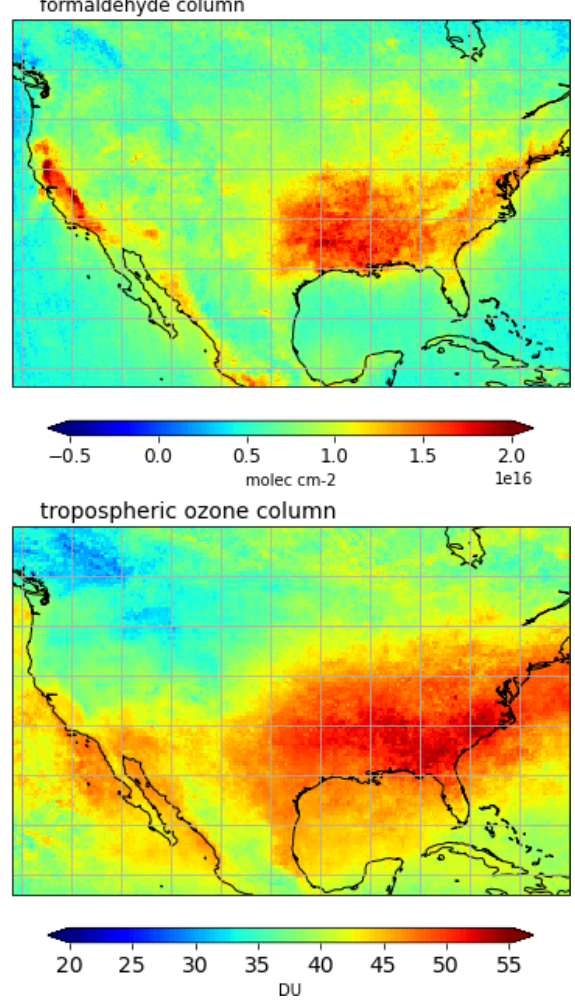
Figure 14. Monthly mean value of S5P formaldehyde (top) and S5P-BASCOE tropospheric ozone (bottom) over the United States observed in July 2018. Formaldehyde is a tropospheric ozone pre-